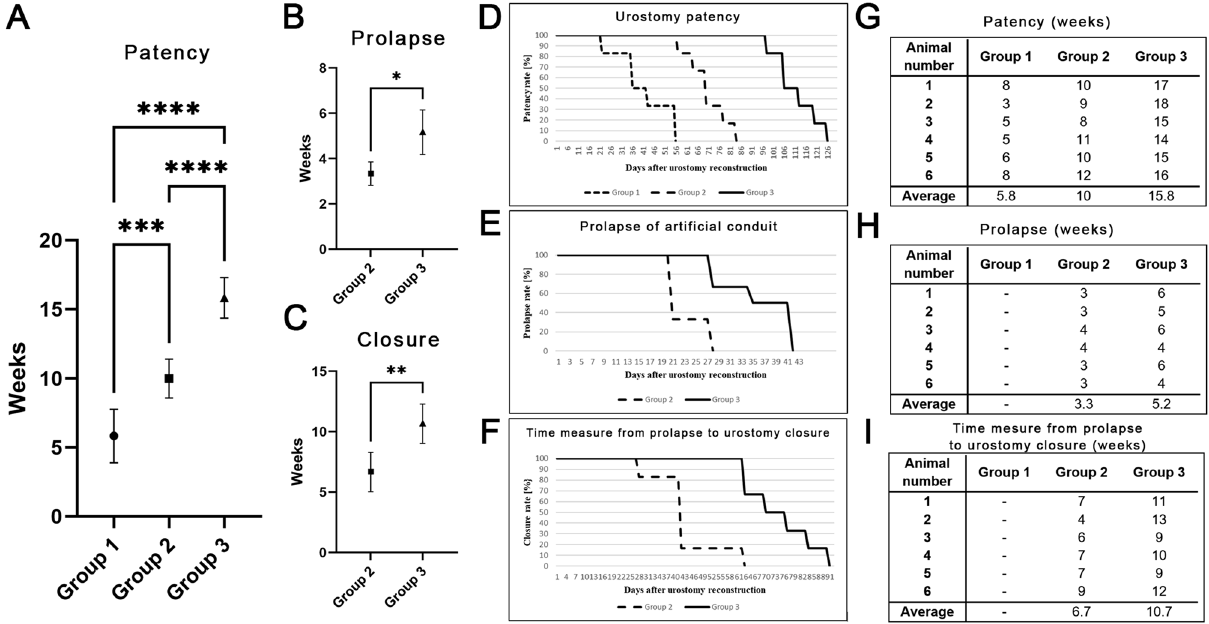
Figure 6. Urostomy evaluation in the presence of patency ( A ), prolapse ( B ), and closure ( C ). Points on the charts show the mean; error bars show the interquartile range. Statistical significance marked with: * < 0.01, **p < 0.02, ***p < 0.001, ****p < 0.0001. Kaplan–Meier patency ( D ), prolapse of artificial conduit ( E ), and time measure from prolapse to urostomy overgrown ( F ) curves after different methods of urostomy formation. ( G – I ) Data from individual animals from each group are summarized in